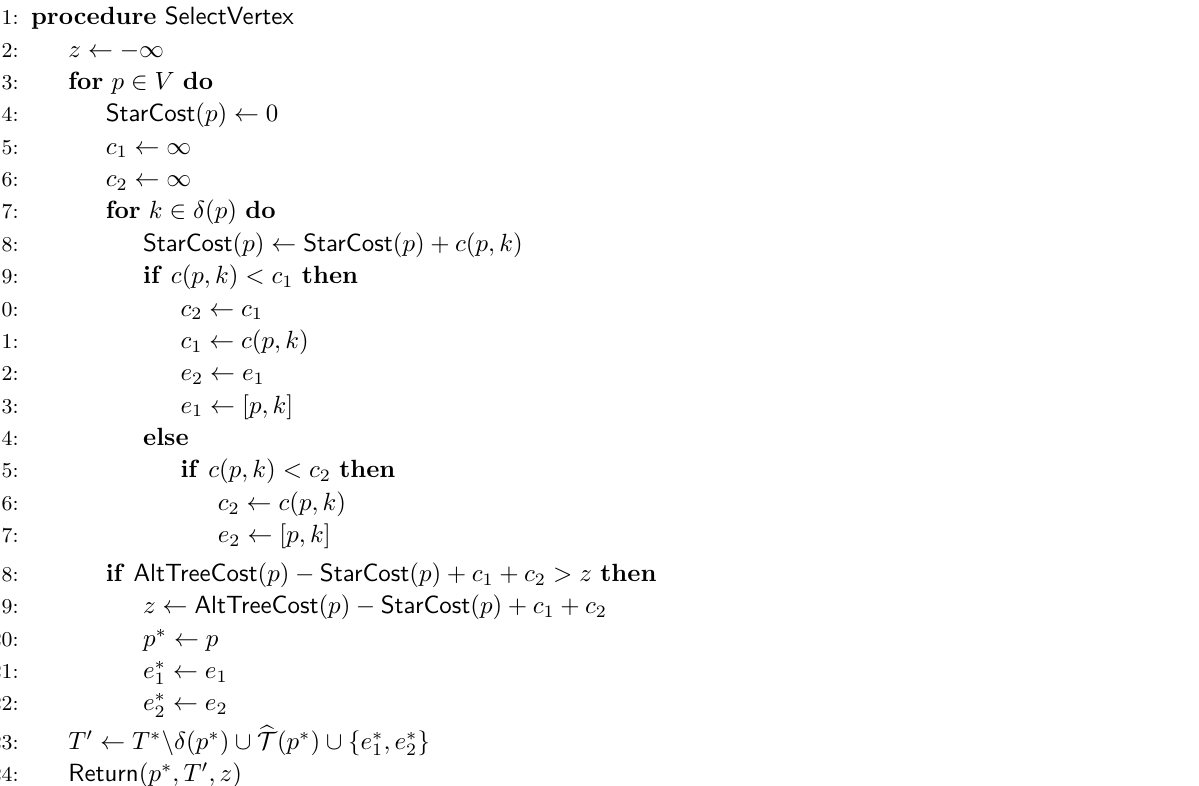
Algorithm 11 The procedure that computes the optimal Held–Karp lower